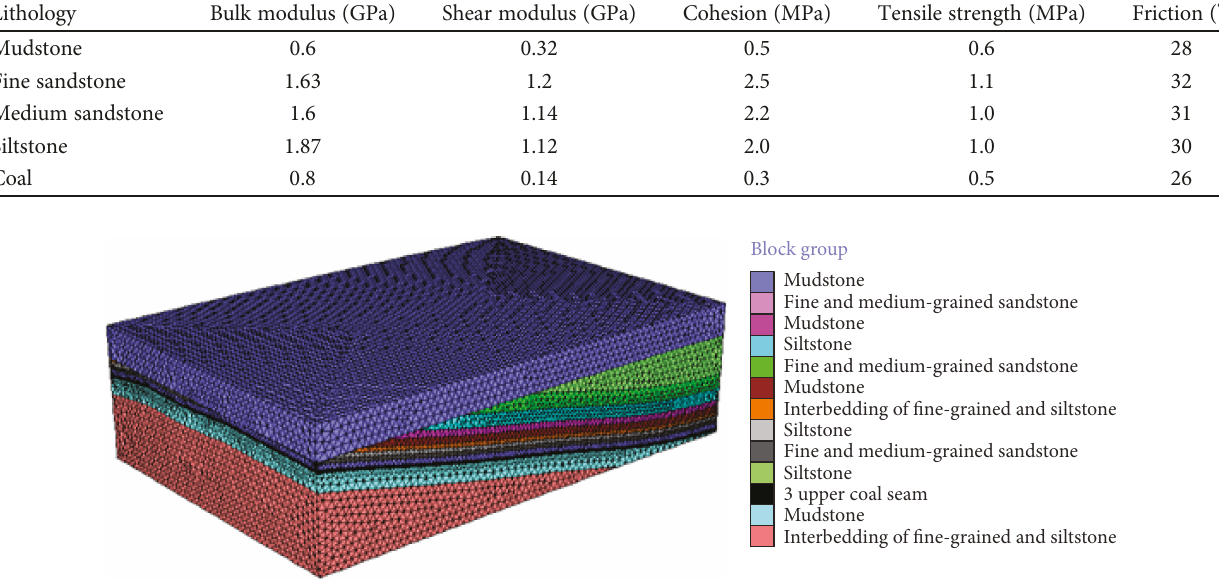
Figure 4: Numerical simulation